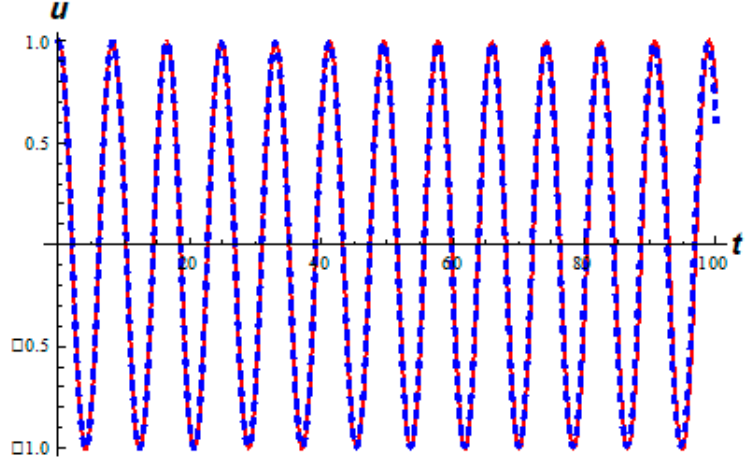
Figure 8. Plots of approximate solution using the MDM (red solid line) and RK4 method (blue dashed line) for 0 ≤ t ≤ 100 and step-size h = 0.5.